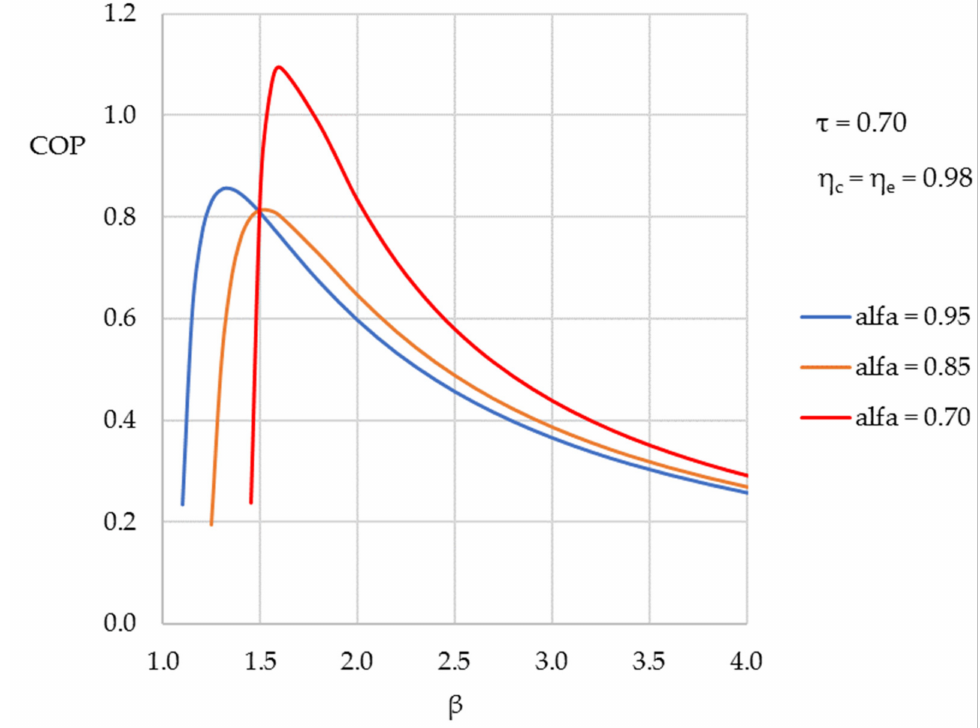
Figure 4. Correlation of the Coefficient of Performance (COP) with the ratio of the magnetic fields β for various values of α , by fixing τ = 0.7 and η e = η c =